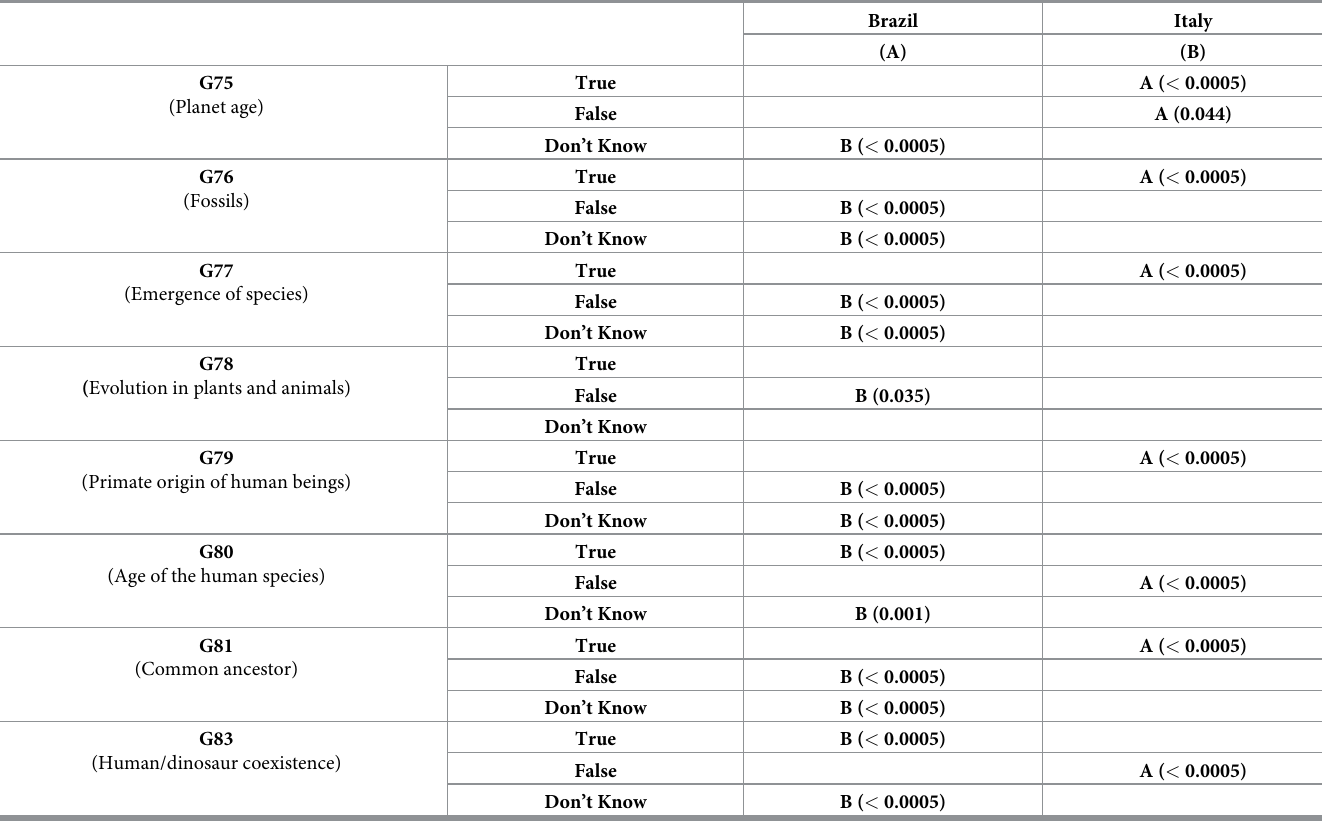
Table 2. Proportion column tests by country (religious group: